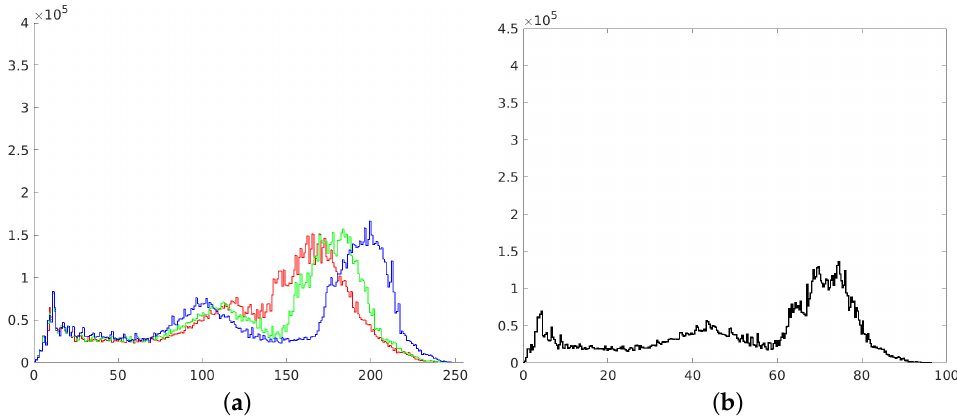
Figure 8. Histograms of RGB channels ( a ) and L channel of L*a*b* space ( b ).